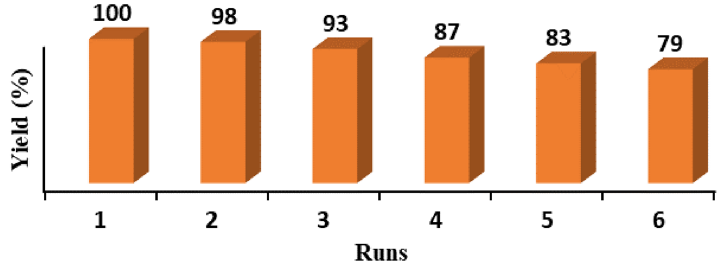
Figure 9. Recyclability of Pd/B-CP-HIm for the model reactions under the optimum reaction condition.